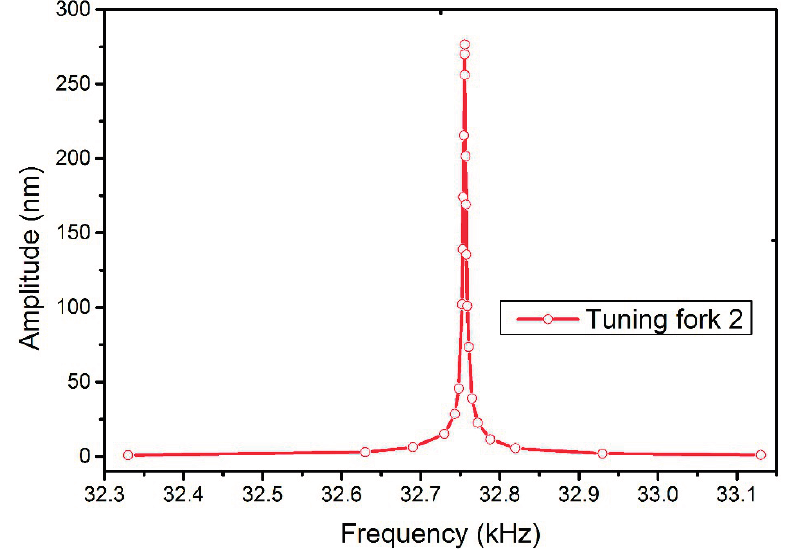
Figure 3. A typical frequency spectrum of a